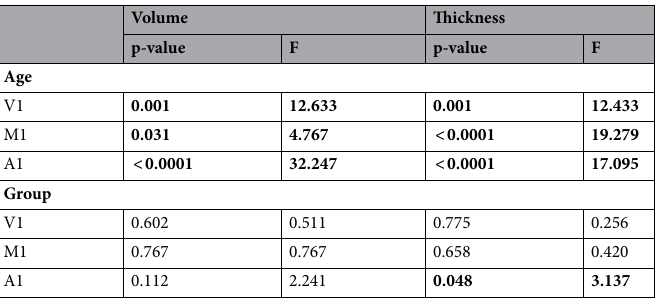
Table 5. The effect of age and group on gray matter volume and thickness in the visual (V1), motor (M1), and auditory cortices (A1). Significant results of multivariate analysis of variance are shown in bold. Adjustment for multiple comparisons: Bonferroni. Top: the effect of age on gray matter volume and surface thickness. Bottom: the effect of group on the gray matter volume and surface thickness, with age included as a covariate.